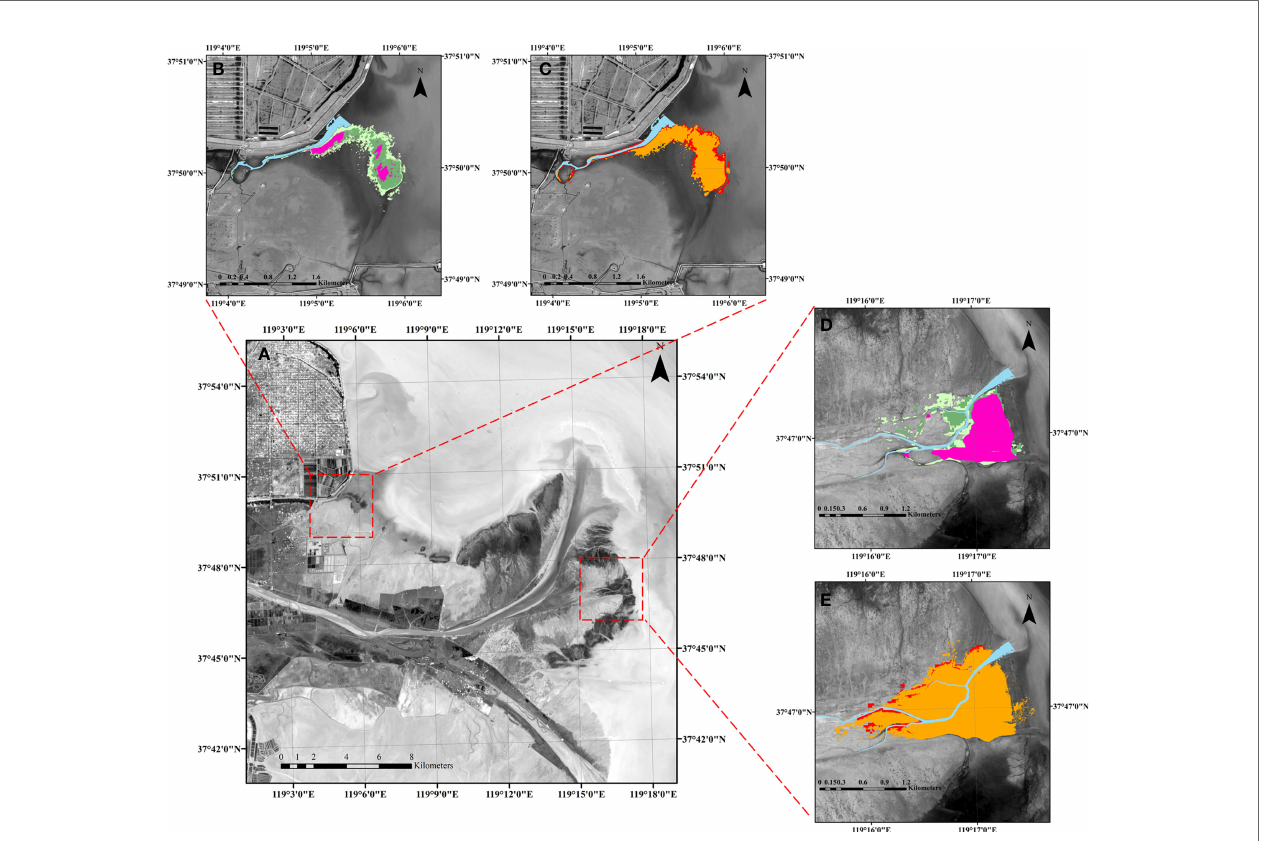
FIGURE 9 | Exemplary cases of S. alterni fl ora landward invasion in the YRD. (A) Regional map of the YRD. (B, C) Are spatio-temporal dynamics of S. alterni fl ora landward invasion in the northern bank of the YRD. (D, E) Are the spatio-temporal dynamics of S. alterni fl ora landward invasion in the southern bank of the YRD. The purple, light green, green, orange and red are the vegetation distribution at the end of the fi rst growing season, second seedling stage, second growing season, third seedling stage, and third growing season,